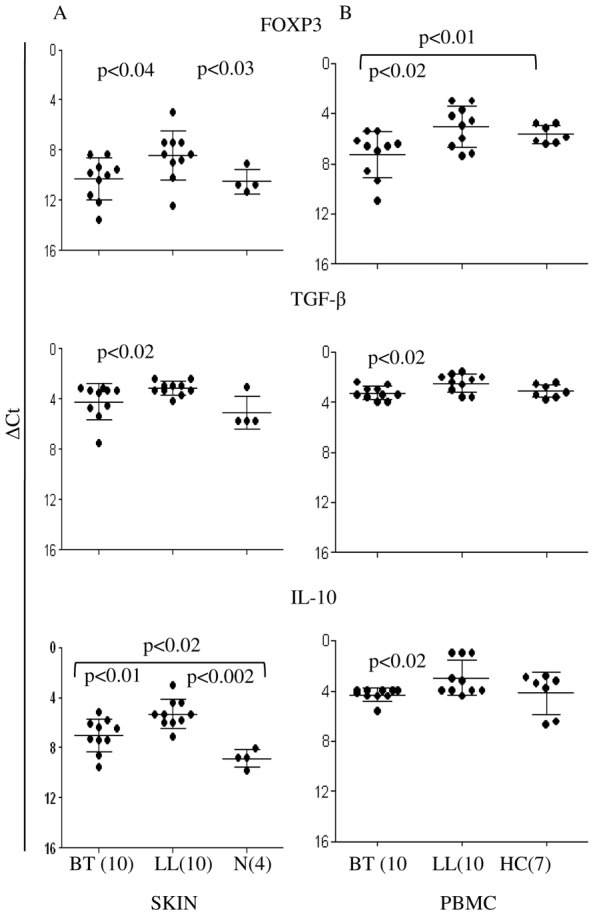
Increase in expression of FOXP3, TGF-β and IL-10 in lepromatous leprosy skin and armadillo derived heat killed Mycobacterium leprae (ML) stimulated in vitro PBMC cultures.Scatter diagram of gene expression (Mean ΔCt ± SD) in skin biopsies (A) and stimulated PBMC (B) of leprosy and healthy/normal subjects. Increase in gene expression was observed in lepromatous as compared to tuberculoid leprosy patients in both local sites and PBMC for FOXP3, TGF-β and IL-10. C. Abbreviations: LL: lepromatous leprosy, BT: borderline tuberculoid leprosy. N: skin from normal subjects undergoing cosmetic surgery. HC: healthy household contacts. Figures in parenthesis indicate number of subjects studied. p<0.05 was considered significant by two tailed Mann Whitney test.